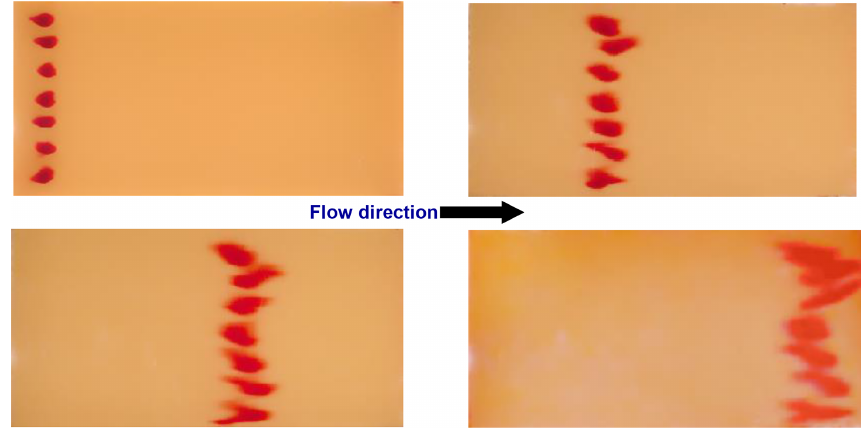
Figure 4. Photographs of dye transport in a flow cell (dimensions 0.86 (length) × 0.45 (height) × 0.10 (width)m) containing a uniform packing of quartz sand (average grain diameter 0.532mm), under a constant flow rate with Pe > 1, at four times (Levy and Berkowitz, 2003; © with permission from Elsevier 2003).